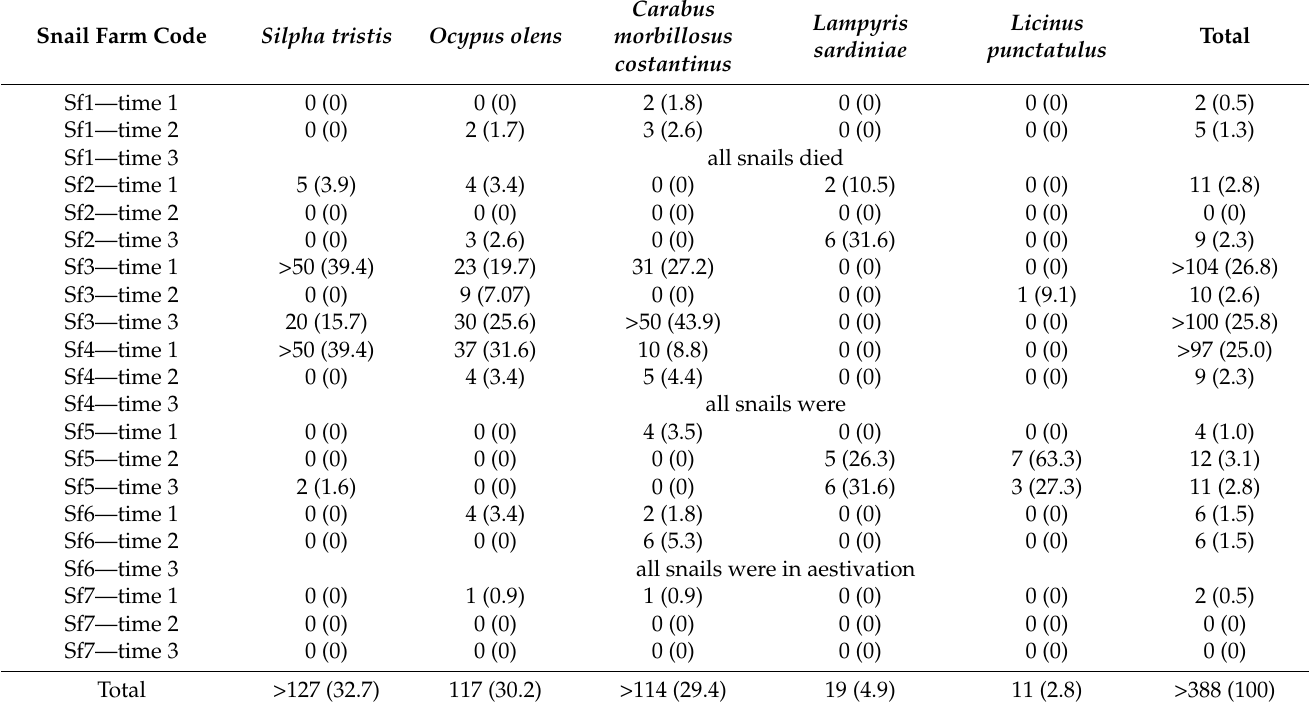
Table 2. Entomological samples collected during the two time periods in the seven involved Sardinian heliciculture farms, by both manual and optical counting. Data are presented as number (percentage). Time 1 refers to the spring–summer season; time 2 refers to the autumn–winter